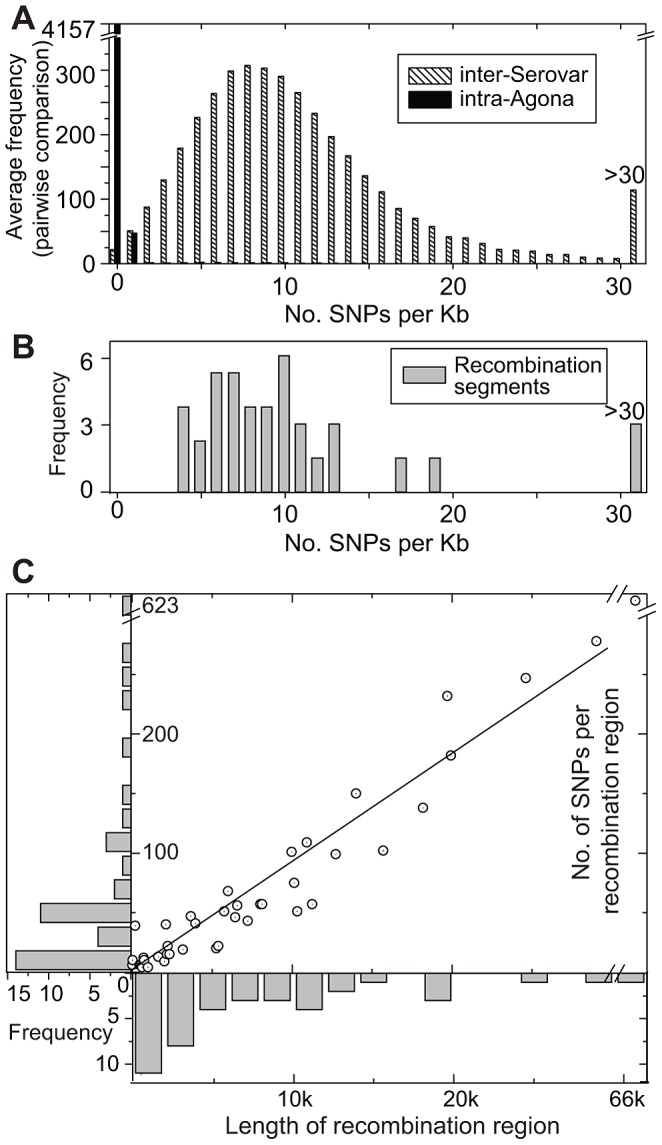
SNP densities in recombinant and non-recombinant regions of the Agona core genome.(A) Average frequency of SNPs per Kb from pair-wise, 1 Kb sliding window comparisons between the genome of Agona SL483 versus 12 genomes from serovars Choleraesuis, Dublin, Enteritidis, Gallinarium, Heidelberg, Newport, Paratyphi A, Paratyphi B, Paratyphi C, Schwarzengrund, Typhi, and Typhimurium (hatched boxes). A comparable distribution of mean pair-wise diversity between all 73 Agona genomes is indicated by black boxes. (B). SNP density in recombination segments. (C) Frequency distributions of the length of recombinant segments (x-axis) and number of SNPs per recombinant region (y-axis). Each recombination region is indicated by an open circle with an internal dot. The linear regression of these data indicates that 9.2 SNPs are found per recombinant Kb (R
2 = 0.97).